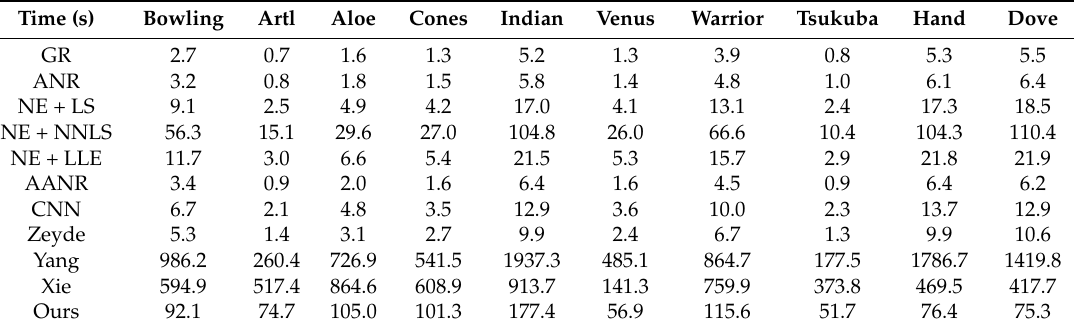
Table 5. Running time on the Middlebury Stereo database with scaling factor